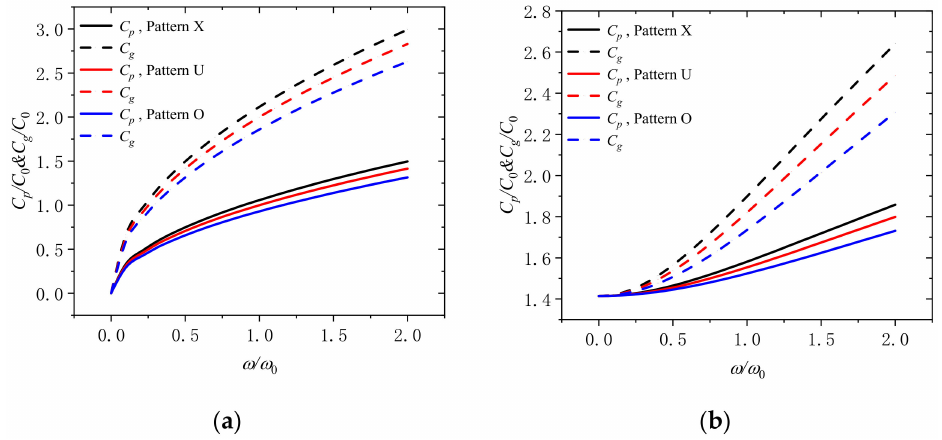
Figure 10. Phase speed and group speed in rotating micro-beam with different distribution patterns of GPLs (Pattern X, Pattern U, Pattern O) for ( a ) Ω / Ω 0 = 0 and ( b ) Ω / Ω 0 = 2. Figure 11 indicates the changes of the wave number with dimensionless frequency for different nonlocal scales ( τ = 0.1, 0.2, 0.3, and 0.4) at the dimensionless rotation speeds of 0